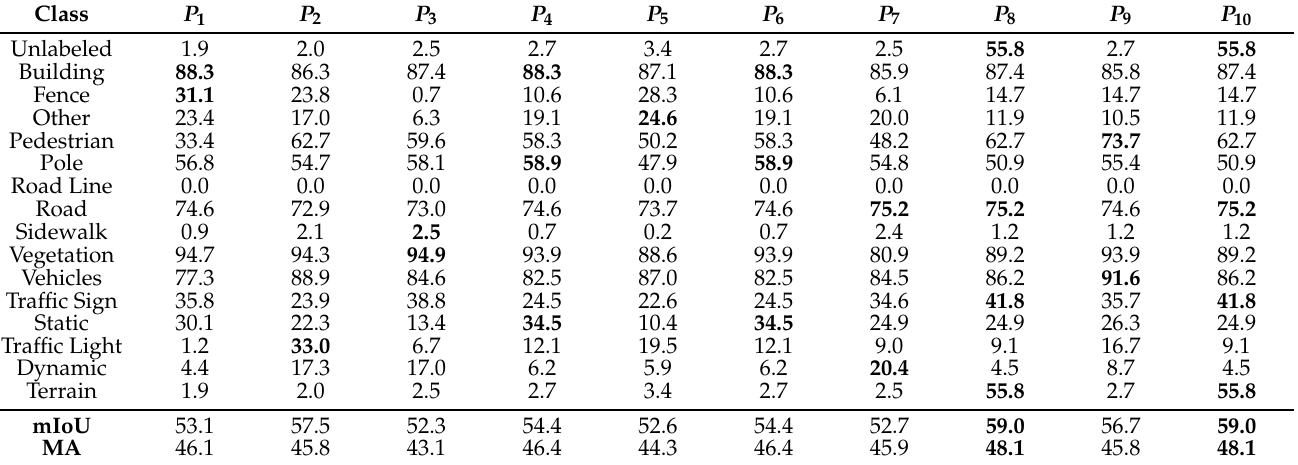
Table 6. Class-based results of SPG on subsets of Paris. Highest values are marked as